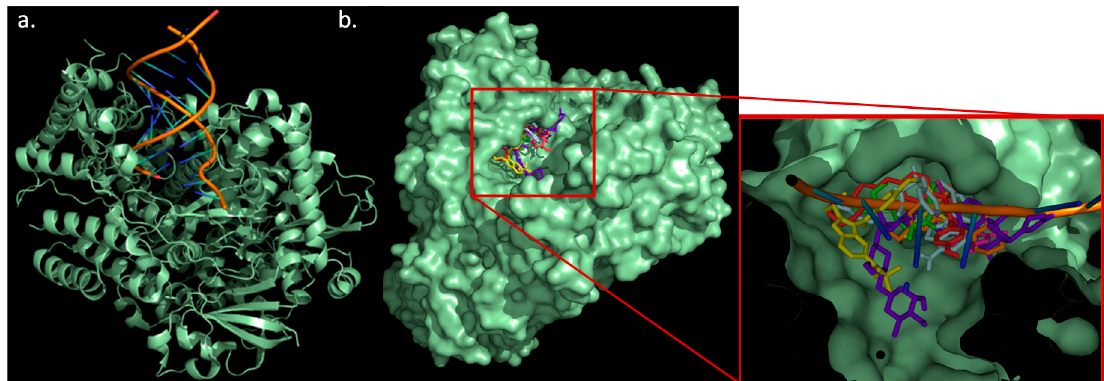
Figure 8. ( a ). RdRp structure. ( b ). Interaction of different drugs with RdRp. Figure 8. ( a ) RdRp structure. ( b ) Interaction of different drugs with